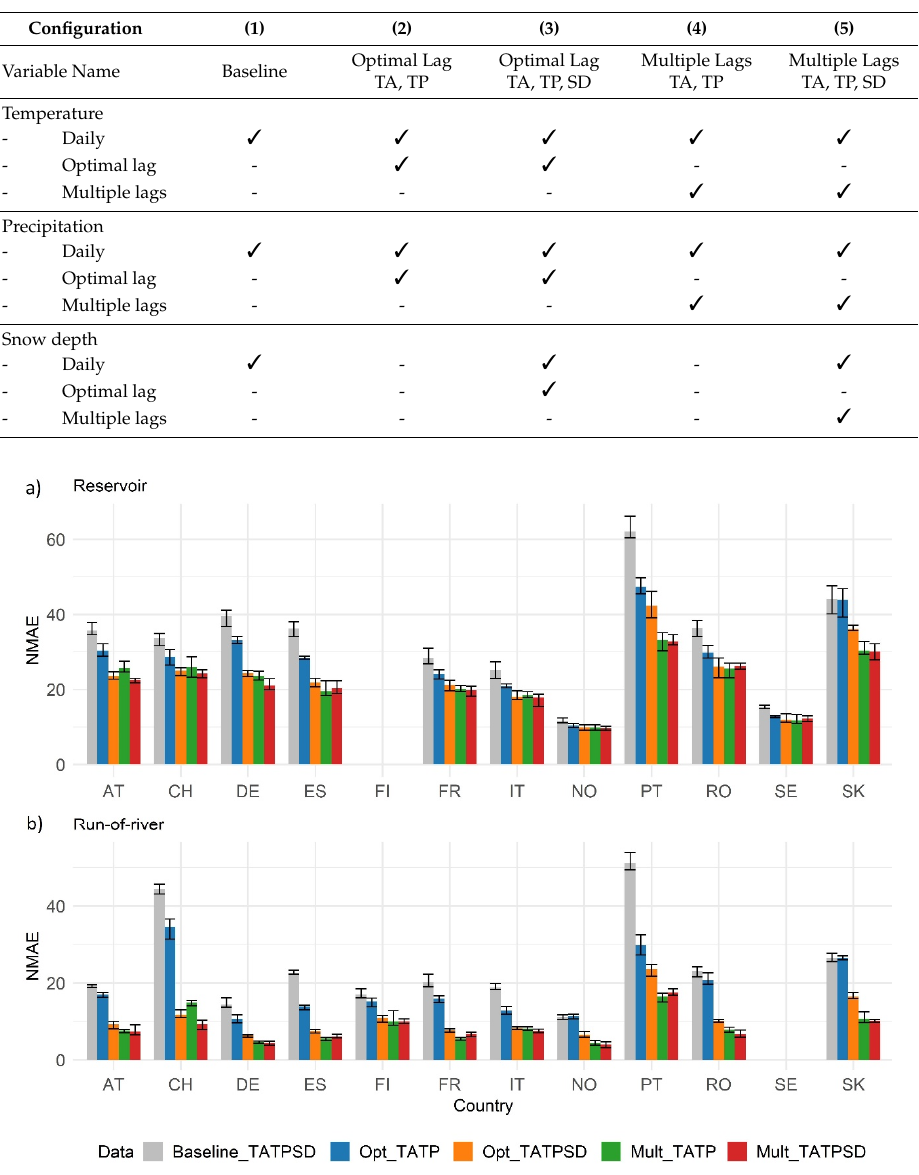
Table 2. The five model configurations (TA = 2 metre temperature, TP = precipitation, and SD = snow depth).